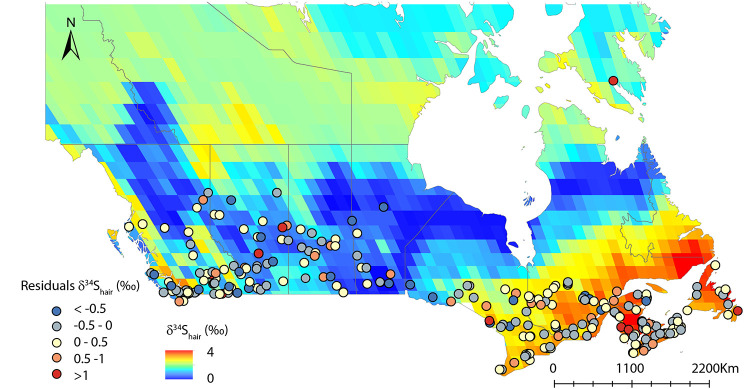
Predicted spatial δ34Shair variability using rainfall, salt aerosol, and soil pH as predictors (resampled at 10,000km2).Colored points represent the associated residuals (modeled δ34Shairvalues–observed δ34Shair values). Administrative boundaries are from http://www.naturalearthdata.com/. This map was generated in Rx64 3 4.2 (https://www.r-project.org/).